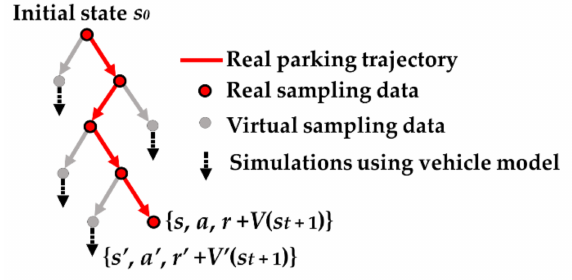
Figure 4. Parking data